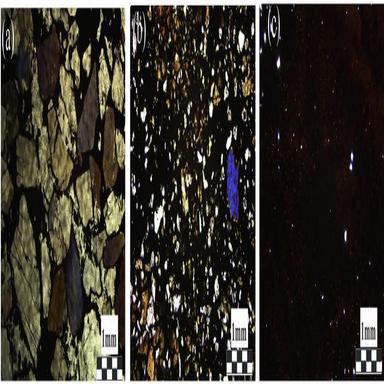
Photomicrographs of the three types of rock samples used to construct FSJM: (a) SJ.R.08/14, corresponding to the ferruginized sandstone (FSS); (b) SJ.R.07/ 14, corresponding to the ferroaluminous lateritic crust (FLC); (c) SJ.R.04/14, corresponding to iron stone (IST).